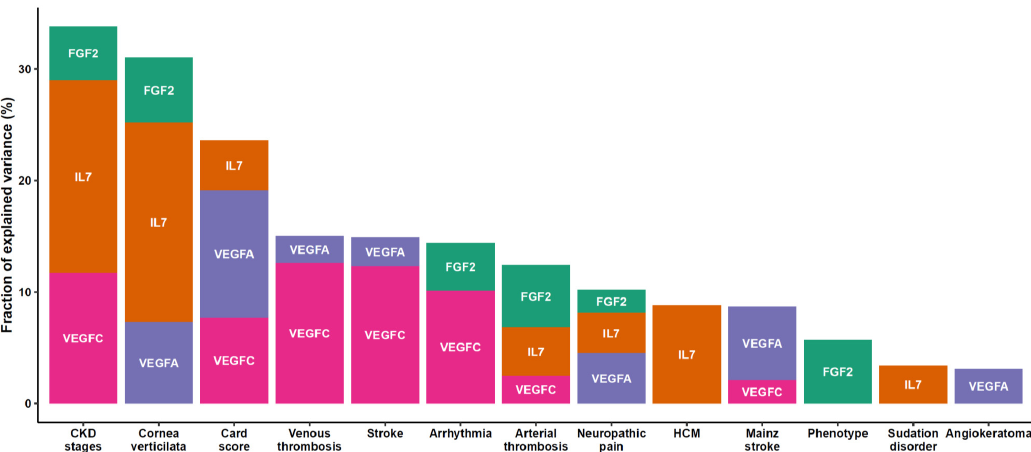
Figure 5. Barplot of variance explanation fraction of FGF2, IL-7, VEGFA, VEGFC, and related clinical characteristics. Colors are related to each protein. CKD; chronic kidney disease. HCM; hypertrophic cardiomyopathy. FGF2; fibroblast growth factor 2, IL7; interleukin 7, VEGFA; vascular endothelial growth factor A, VEGFC; vascular endothelial growth factor C.